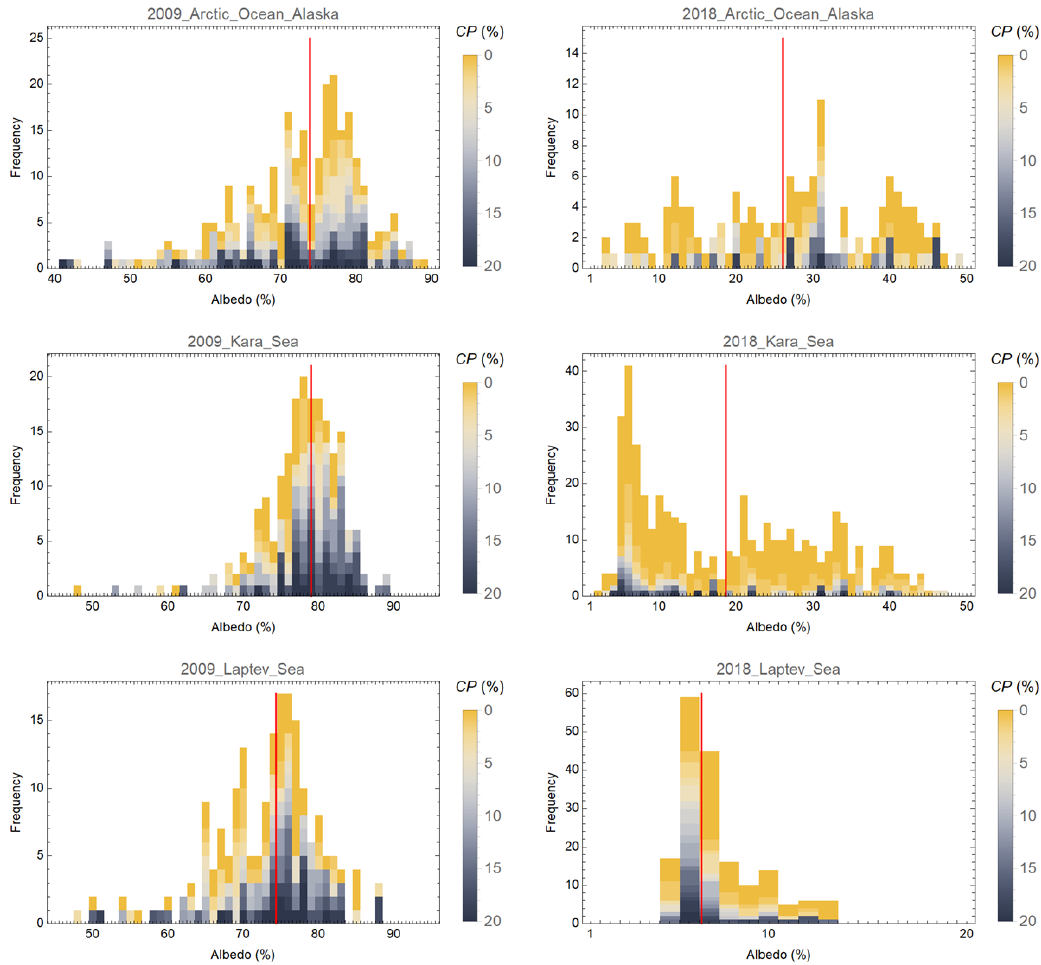
Figure 6. The albedo retrieval distributions at the Arctic Ocean (73.370 ◦ N, 139.180 ◦ W), Kara Sea (2.680 ◦ N, 62.860 ◦ E) and Laptev Sea (75.320 ◦ N, 125.720 ◦ E) in April 2009 and July 2018. The cloud probability values of the individual black-sky satellite-based estimates are indicated by colours. The monthly mean estimate is shown as a red